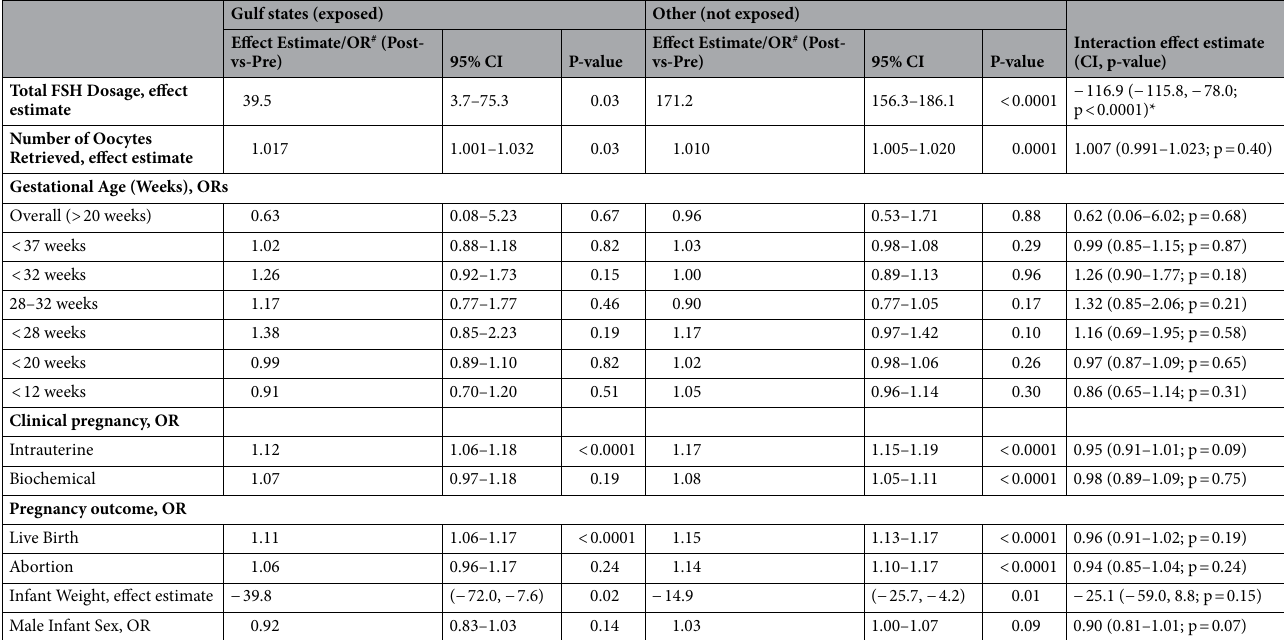
Table 2. Multivariable analysis adjusting for age, maximum FSH levels, gravidity, and infertility diagnosis. *Significant p-value. # OR odds